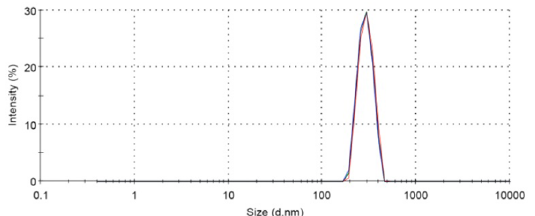
Figure 12. Batch 10 size distribution x intensity